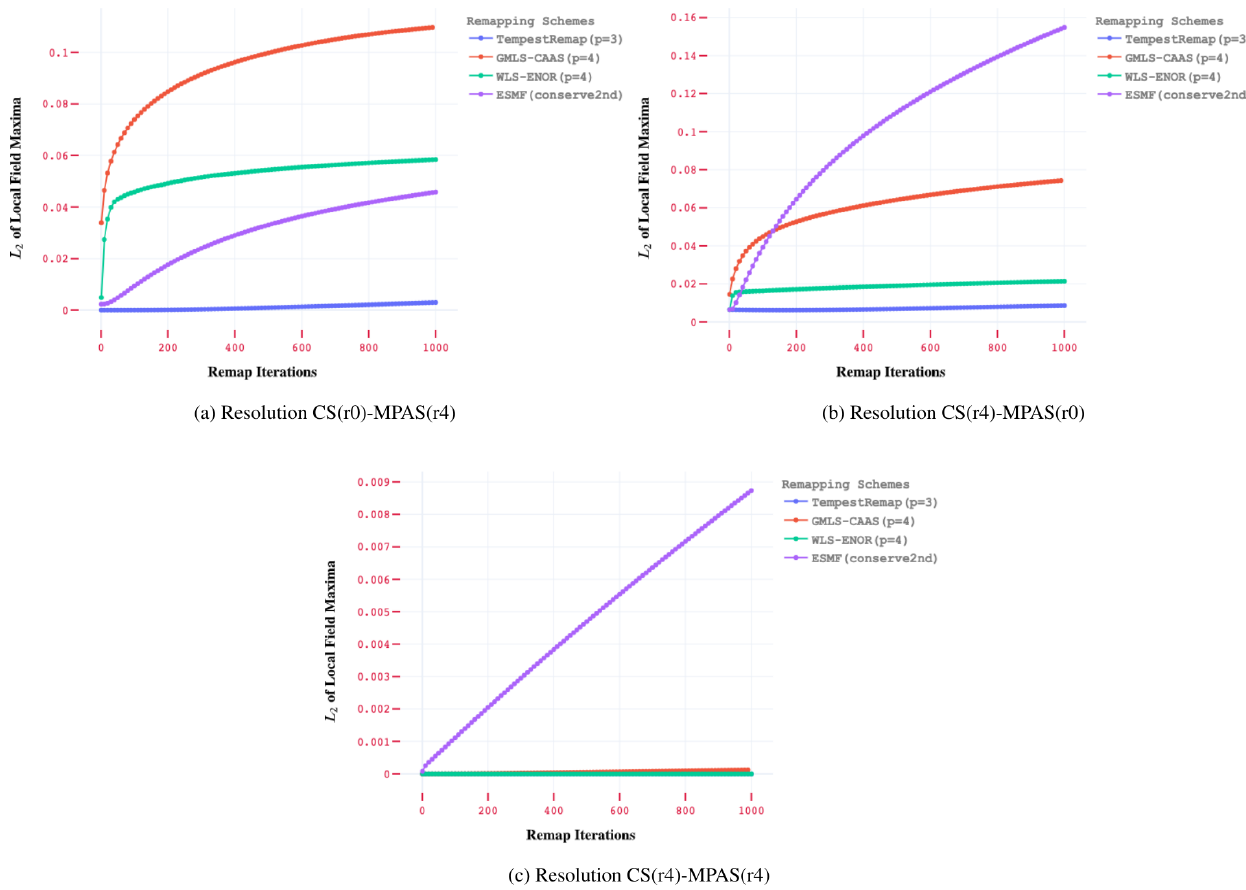
Figure 10. L max , 2 metric for the TPW field on CS-MPAS meshes with different